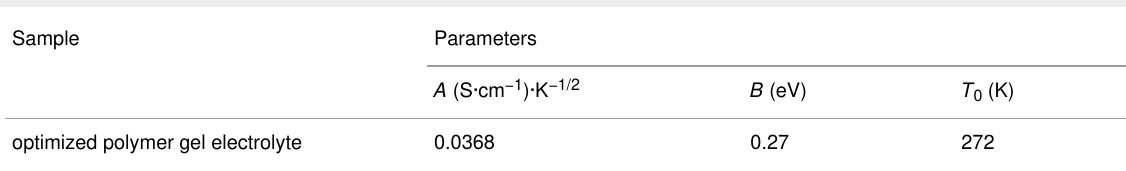
Table 2: Non-linear fitting parameters from the VTF equation.